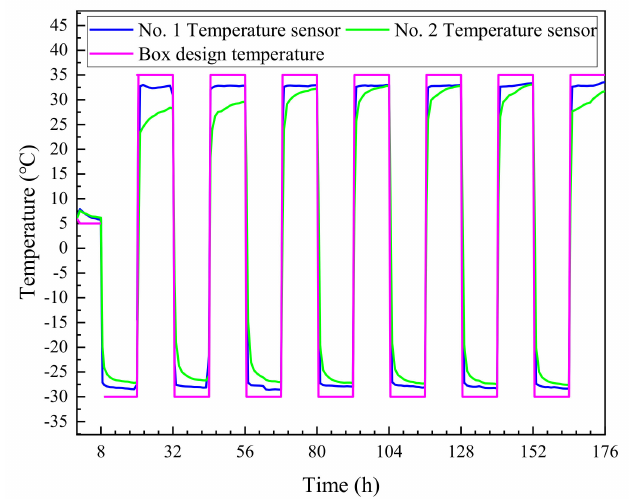
Figure 3. Test site layout: ( a ) Multifunctional physical simulation test platform ( b ) Soil column ready for test.